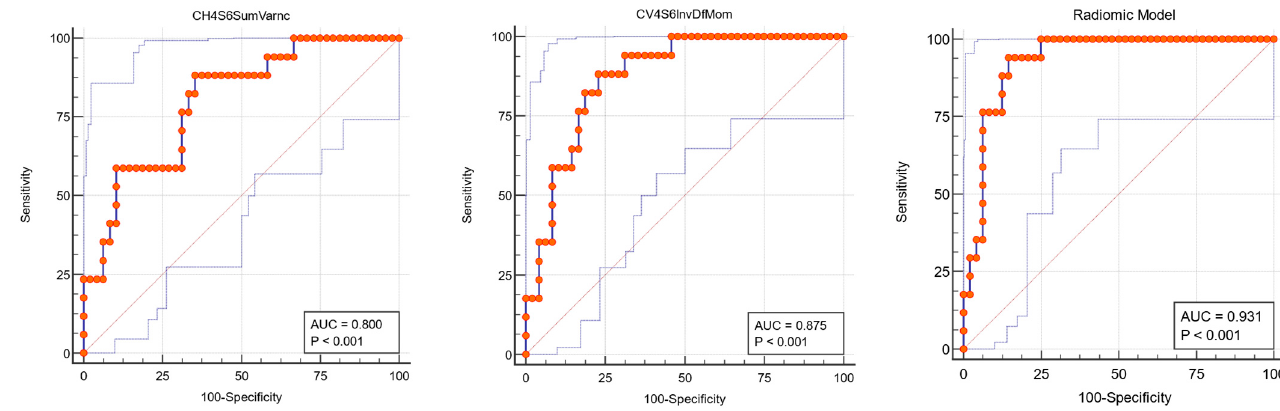
Figure 4. Receiver operating characteristics (ROC) curve of the independent parotid glands’ texture features (CH4S6SumVarnc, CV4S5InvDfMom) and the resulting radiomic model, associated with lymphoma development in patients with primary Sjögren’s syndrome (orange dotted line—ROC curve; thin blue lines—ROC Confidence Interval).